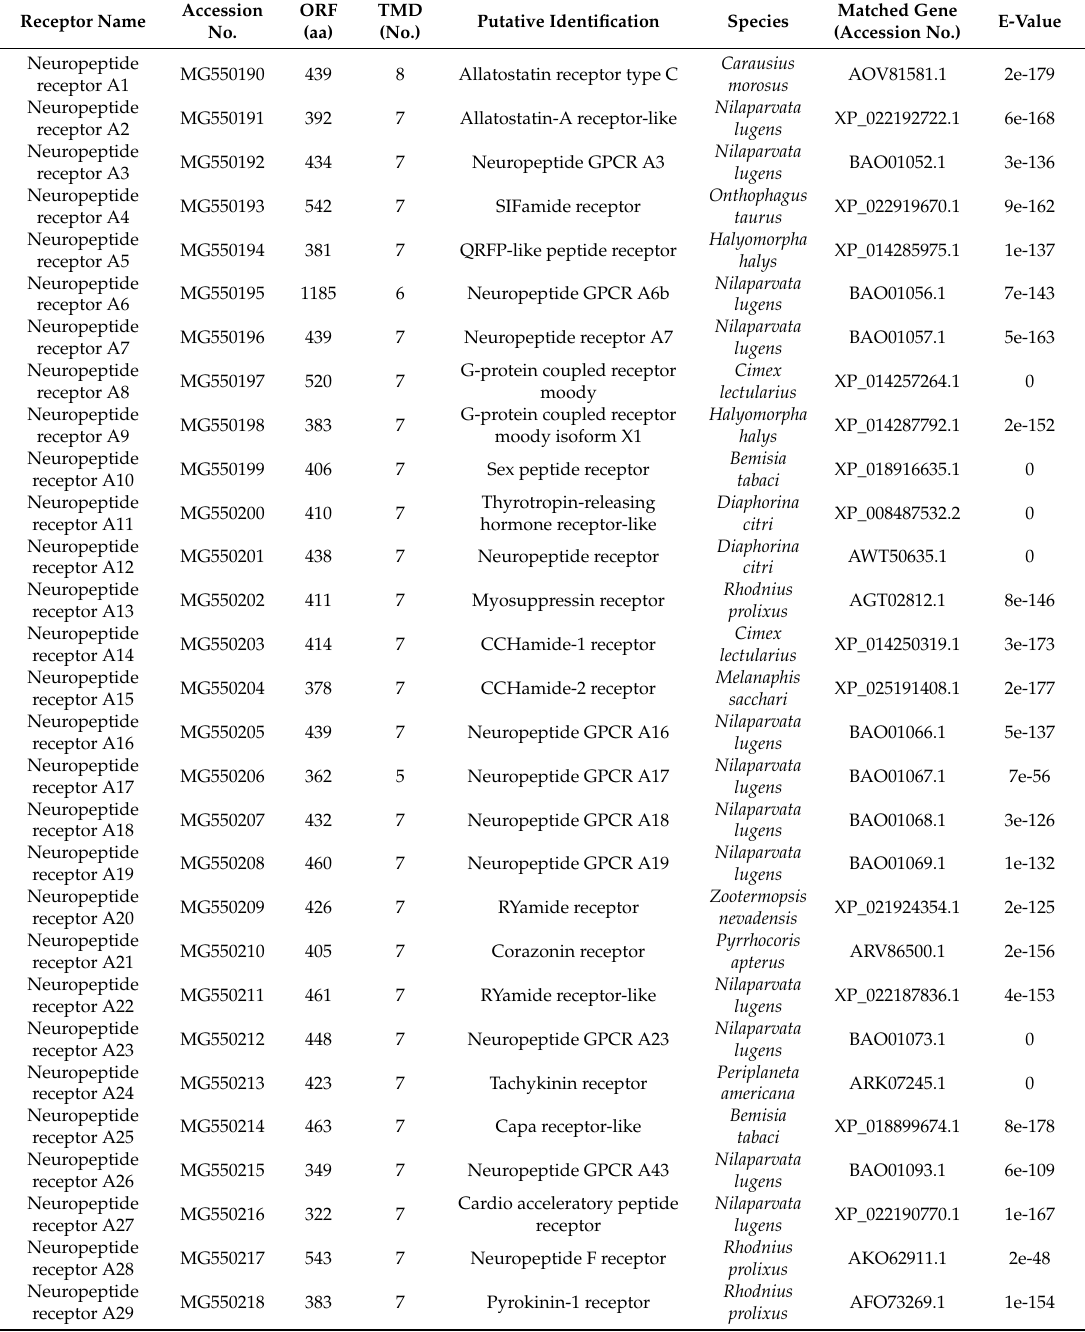
Table 2. Neuropeptide G-protein-coupled receptor (GPCR) genes identified from D. citri . ORF, open reading frame; aa, amino acid; TMDs, transmembrane